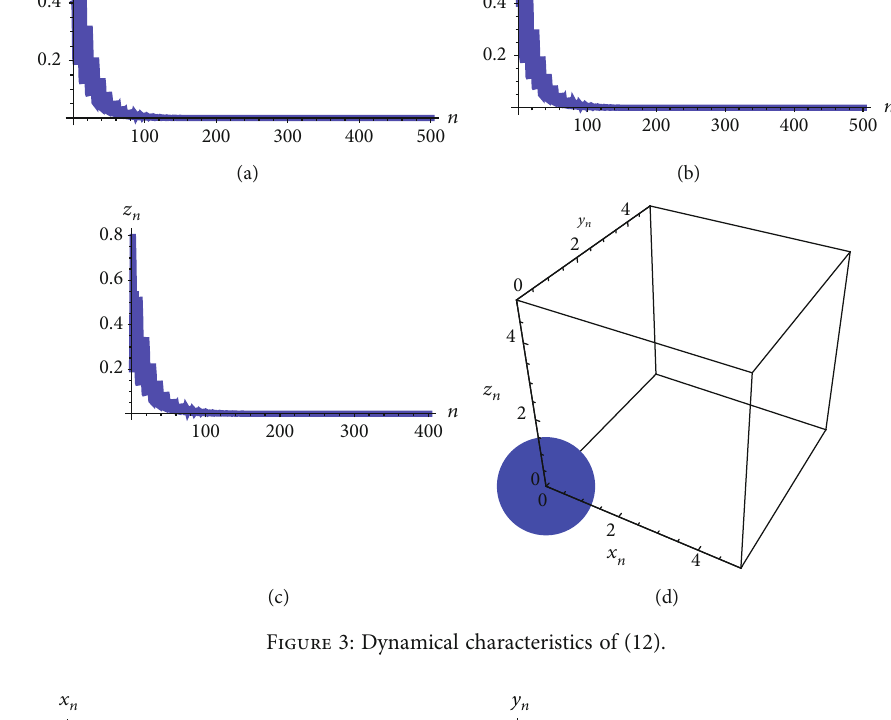
Figure 3: Dynamical characteristics of (12).